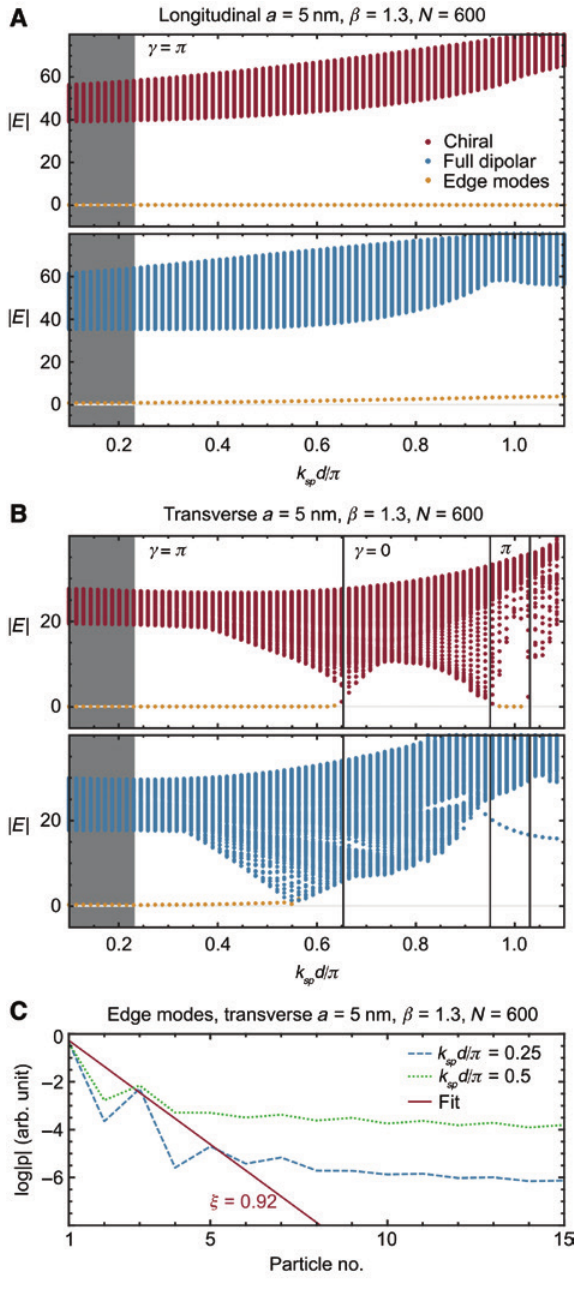
Figure 3: The eigenvalues of the chiral (red) and full dipolar (blue) topological plasmonic chain with changing k d . sp (A) Longitudal and (B) transverse polarizations. Topologically protected edge modes are yellow. The dark grey area indicates the region where the CDA is not valid as the particles are too closely spaced. The vertical black lines indicate the Zak phase transitions as predicted by the closing of the bulk gap. (C) The edge mode profiles of (B) blue for different choices of k d sp zero for some value of k d for β = 0.7, then G is zero for the sp 21 same k d for β = 1.3. Therefore, for β = 0.7 the Zak phase is sp exactly opposite to β = 1.3 for all k d . sp